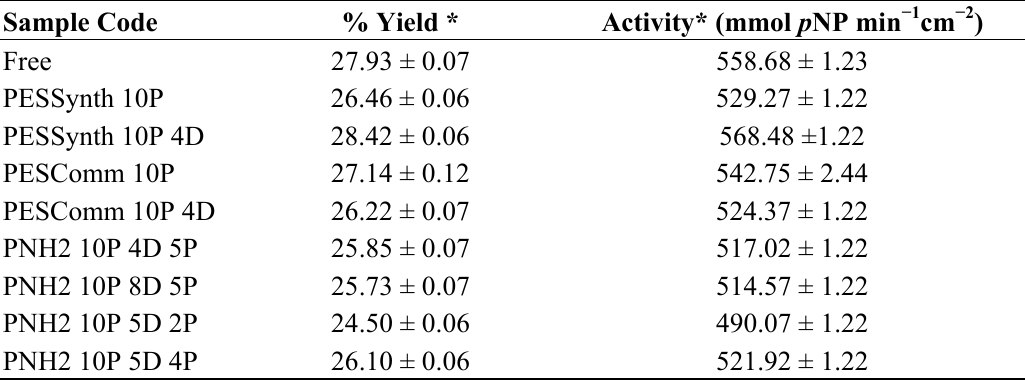
Table 2. Hydrolytic activity test result of Mucor miehei